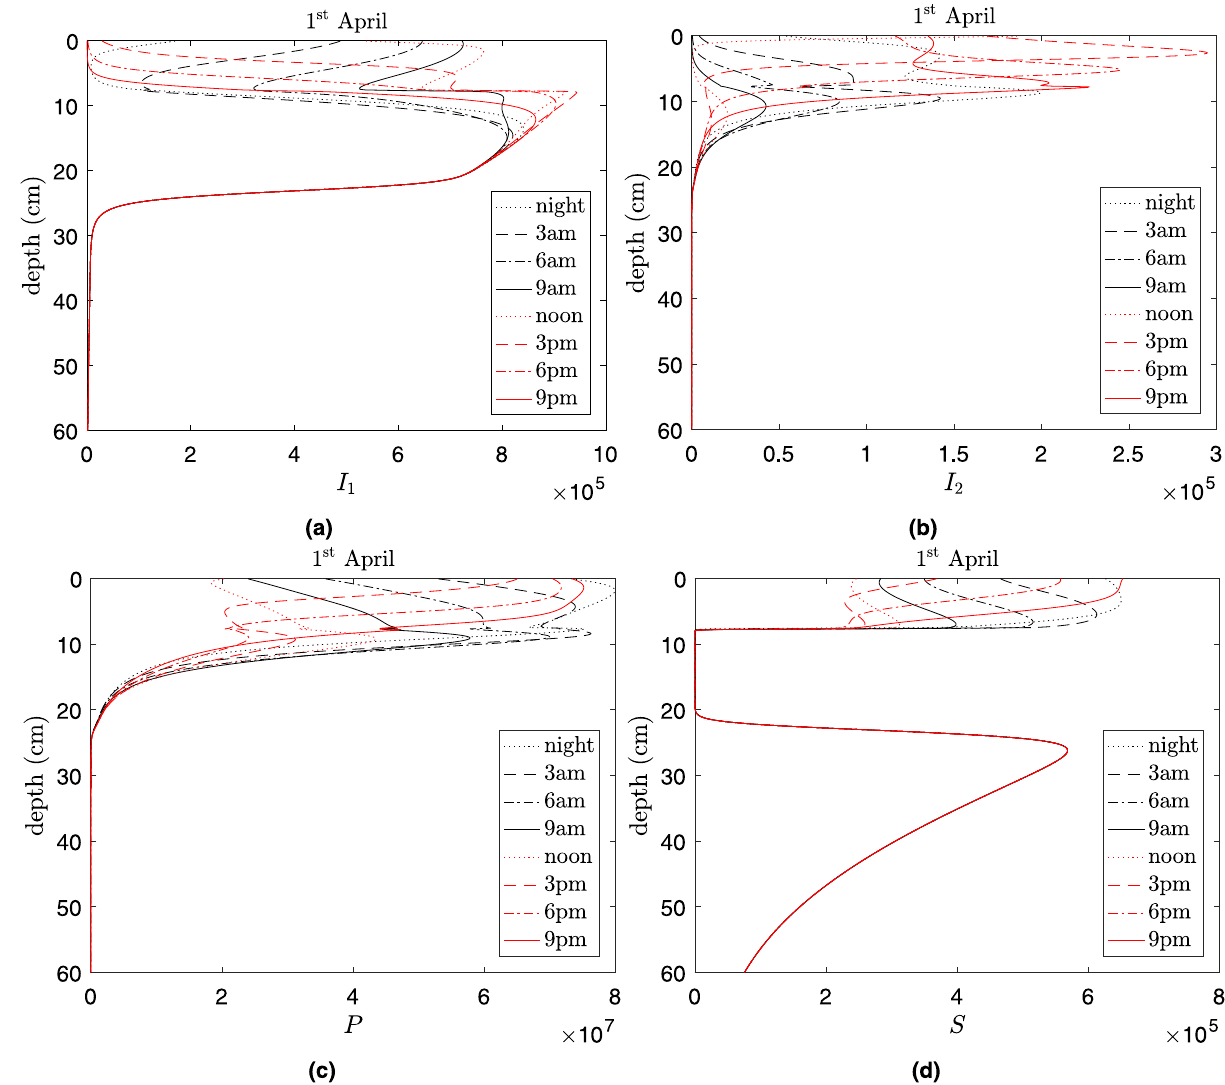
Figure 5. Vertical distribution of infected bacteria predicted by the model ( a ): in lytic I 1 , ( b ): in lysogenic I 2 , ( c ): phage P and ( d ): susceptible bacteria S in the soil across the day of April 1st predicted by the model calculated for Nakhon Phanom province. Model parameters are taken from Table 1 as default values. Note that the curves in (d) overlap for depths h >20cm. The unit of the densities of bacteria and phages are cell/ml and phage/ml,